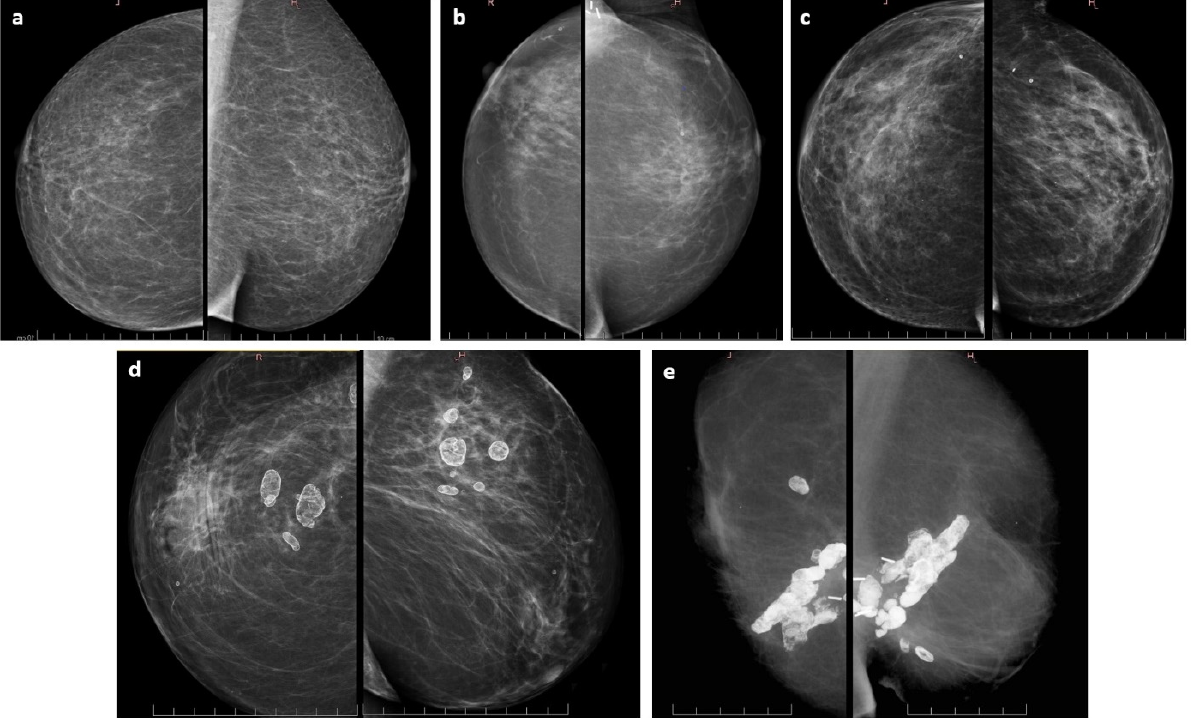
Figure 4. Control mammography findings (own material)—each left picture is a craniocaudal (CC) view. Each right image is the mediolateral oblique (MLO) view: ( a ) no secondary changes, ( b ) slight scarring of tumor bed, ( c ) scarring changes accompanied with dispersed and tiny benign calcification, ( d ) scarring tissue containing asymptomatic macrocalcifications formed in fat necrosis foci, and ( e ) a single example of clearly palpable and symptomatic massively calcified fat